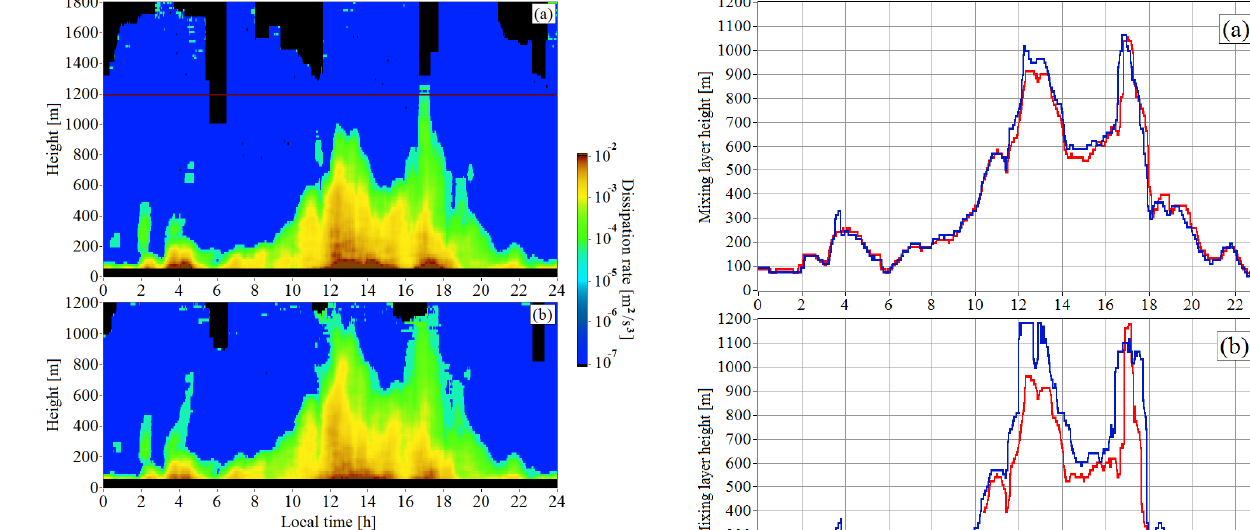
Figure 2. Height and time distributions of the turbulence energy dissipation rate at elevation angles of 60 ◦ (a) and 35.3 ◦ (b) . Mea- surements were taken on 21 July 2019.